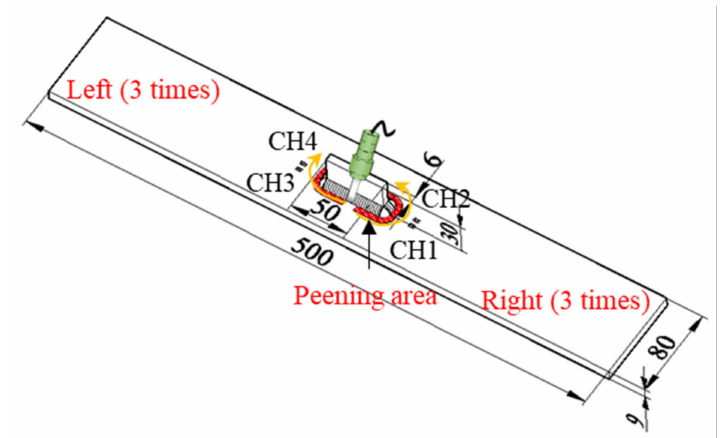
Figure 1. The specimen geometry (mm).